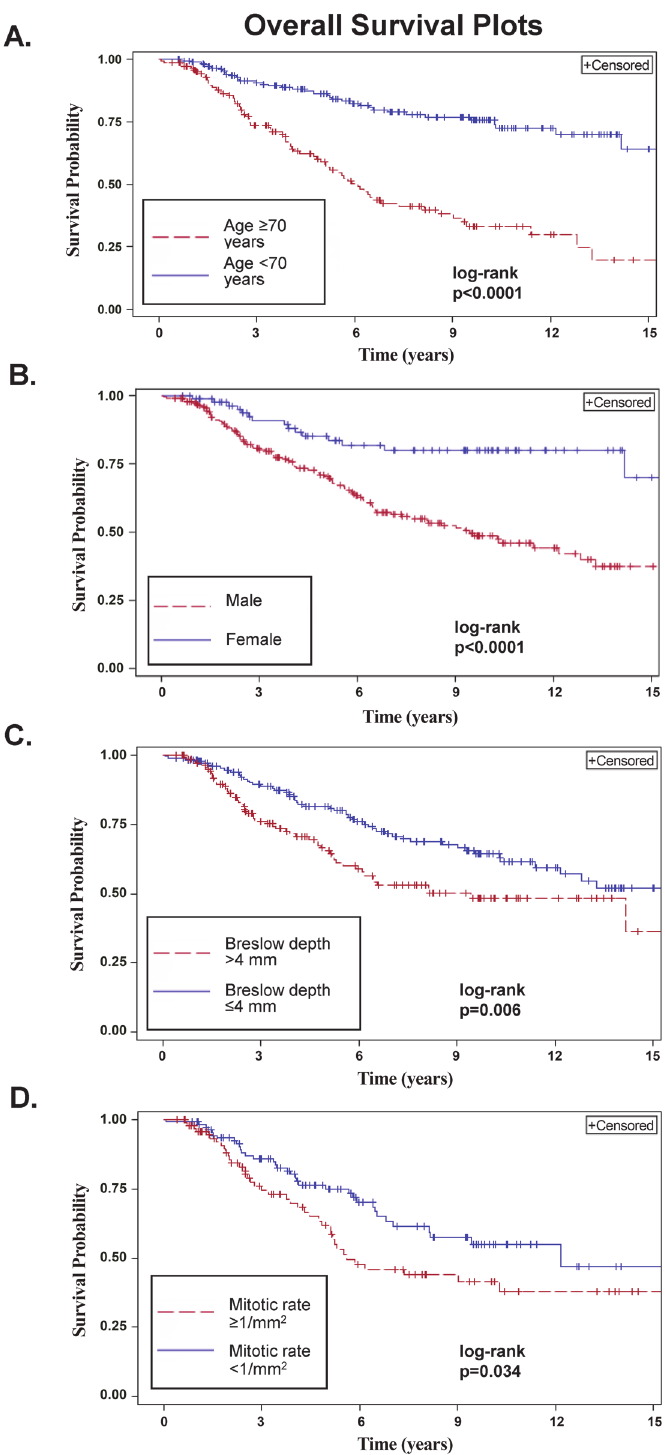
Fig 2. Impact of clinicopathologic factors on overall survival (OS) in patients with clinically localized desmoplastic melanoma. A. OS by age ( (cid:1) 70 vs. < 70 years). B. OS by gender. C. OS by Breslow thickness ( (cid:3) 4 mm vs. > 4 mm). D. OS by mitotic rate ( (cid:1) 1/mm 2 vs. < 1/mm 2 ).